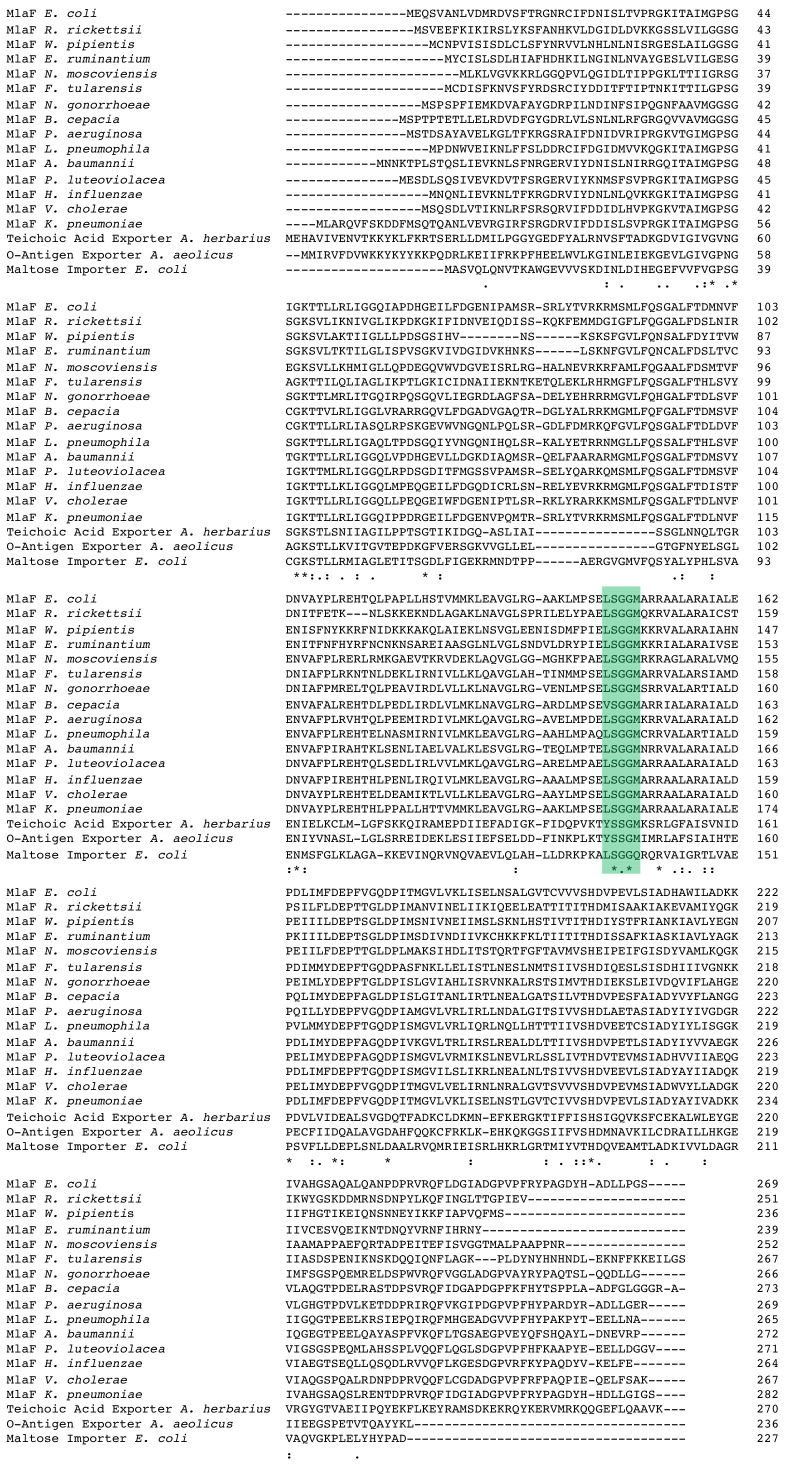
Sequence alignment of Mla, TGD-like MCE systems, o-antigen and teichoic acid transporter.The conserved LSGGQ/M motif is highlighted in green.